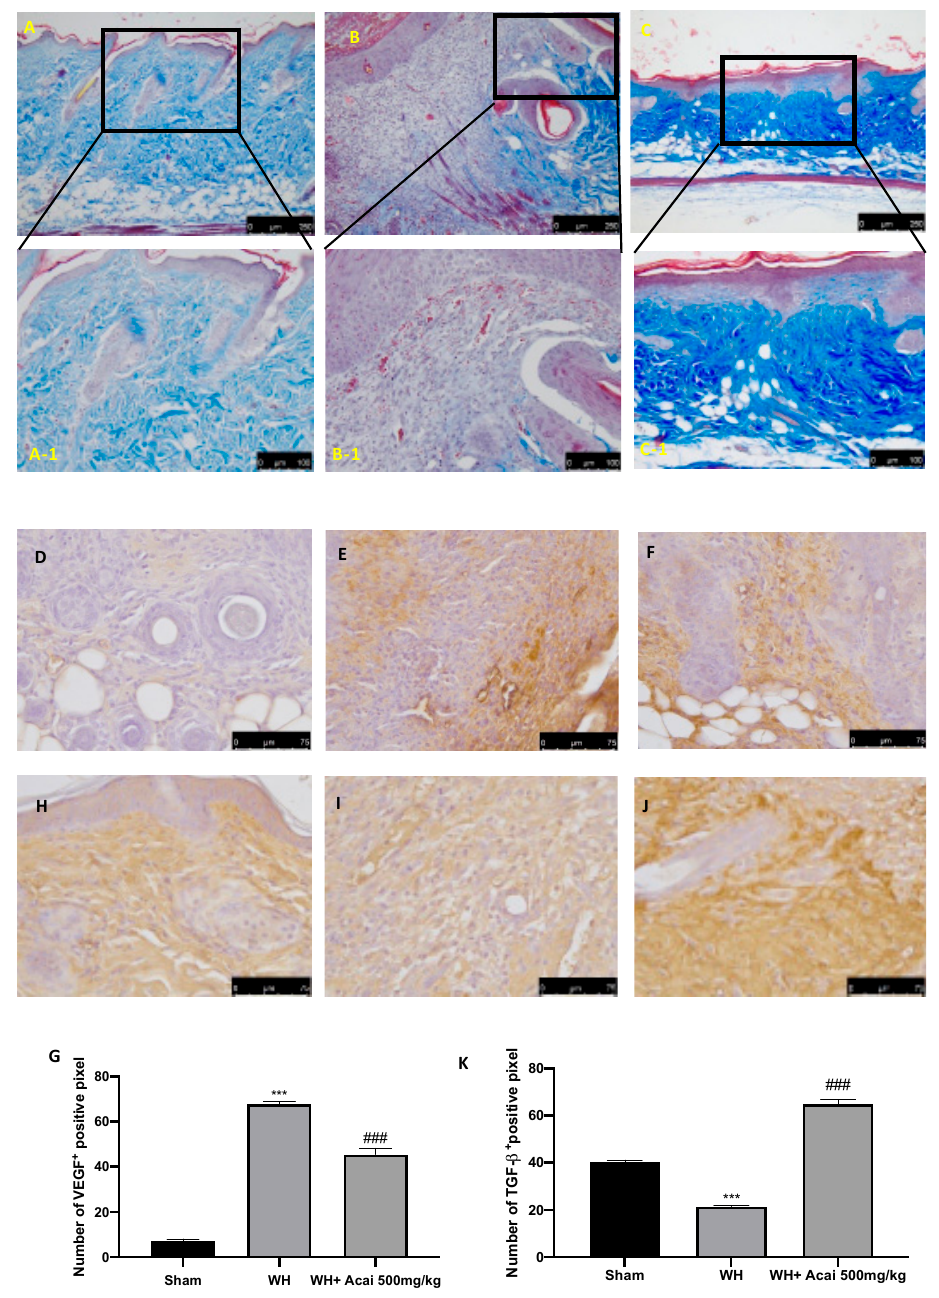
Figure 3. Masson’s trichrome staining to observe changes in dermal collagen through optical microscopy; sham ( A , A-1 ), WH ( B , B-1 ), WH + açai berry ( C , C-1 ). A 10× and 20× magnification is shown. Immunohistochemical analysis of VEGF ( G ) and TGF- β ( K ); sham ( D , H ), WH ( E , I ), WH + açai berry ( F , J ). A 75 × magnification is shown. A demonstrative blot of lysates with a densitometric analysis for all animals is shown. Data are expressed as the mean ± SEM of N = 6 mice/group. *** p <0.001 vs. sham; ### p < 0.001 vs. WH.